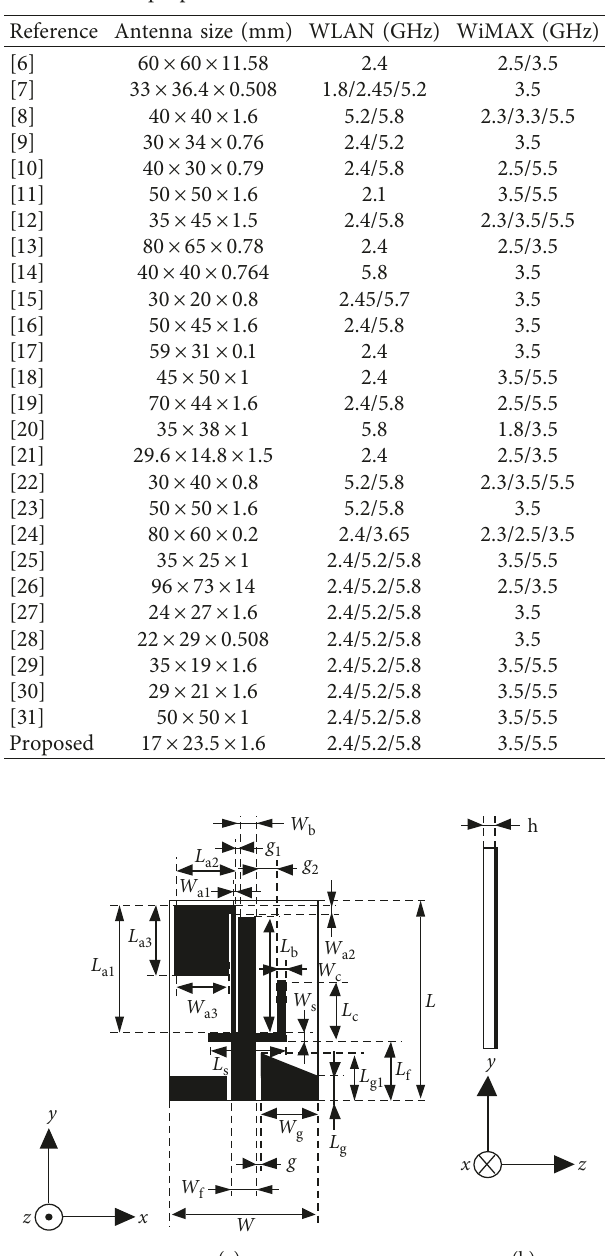
Table 1: Comparison between the existing WLAN/WiMAX an- tennas and the proposed triband antenna.